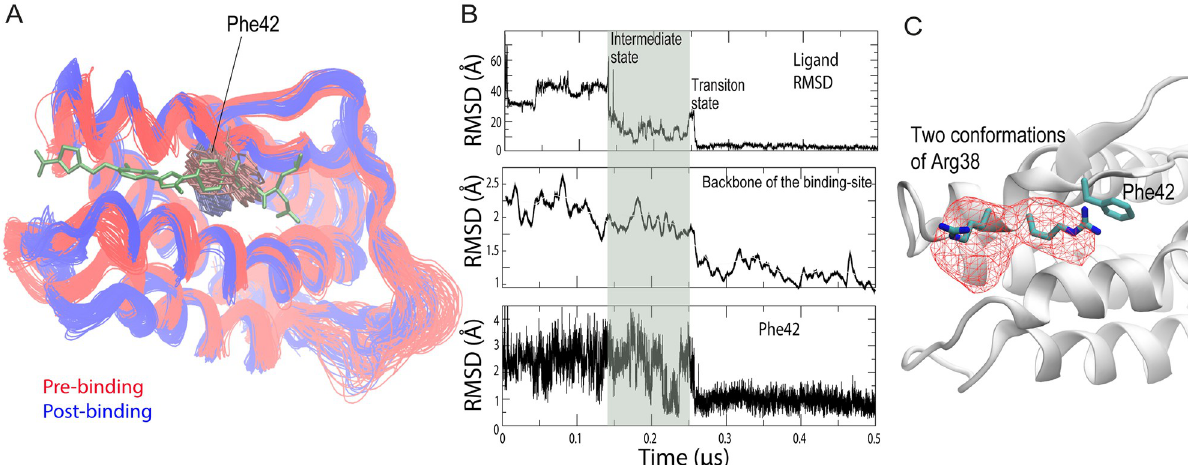
Fig 4. Emergence of the binding groove. (A) Conformations of the IL2 backbone and Phe42 before and after SP4206 binding. Multiple conformations from the binding simulation discussed in Figs 1 and 3 are superimposed. The backbone of the residues lining the long-side edges of the SP4206 binding groove moved further apart, and Phe42 was stabilized in a single rotamer after binding. (B) Top panel: the time series of SP4206 RMSD with respect to the crystal binding pose (identical to the top panel of Fig 1D); middle panel: two running averages (of different widths of the averaging window) of the RMSD of the backbone of the residues lining the long-side edges of the binding groove (residues 32–44, 63–74) with respect to the SP4206-bound conformation; bottom panel: RMSD of Phe42 with respect to the SP4206-bound conformation. (C) The spatial occupancy (mesh) of the two conformers of Arg38 from a 5- μ s simulation of apo IL2, in which SP4206 and other small molecules were not present.